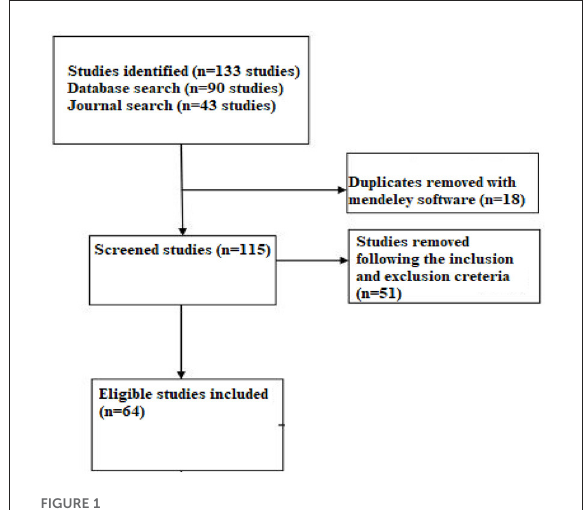
FIGURE1 Procedure for selecting